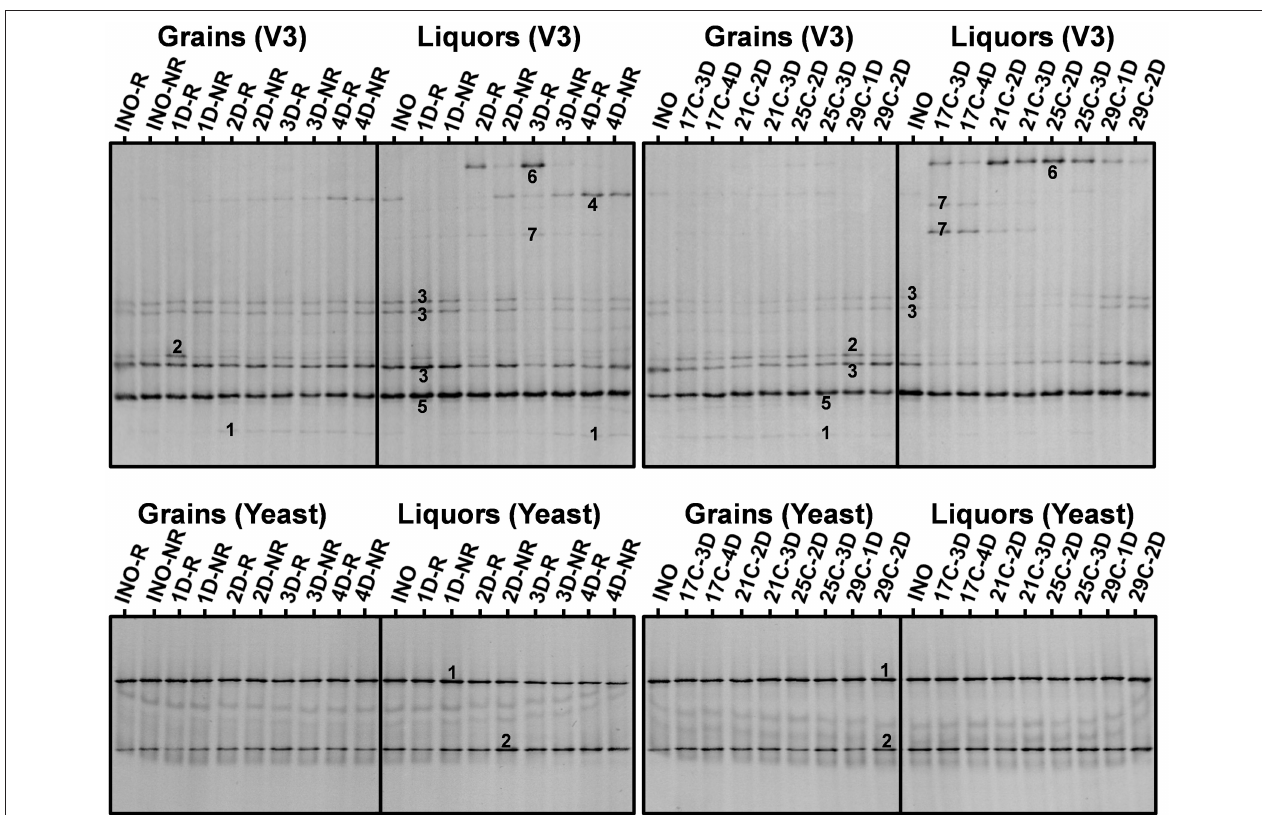
FIGURE 3 | Culture-independent species diversity of the rinsed (INO-R) and non-rinsed (INO-NR) grains and liquor of the grain inoculum (INO) and of the non-rinsed grains and liquors of the eight series of water kefir fermentations differing in backslopping time and rinsing of the grains during each backslopping step, at the end of backslopping step 8 (left), as well as of the non-rinsed grains (INO) and liquor of the grain inoculum (INO), and the non-rinsed grains and liquors of the eight series of water kefir fermentations differing in incubation temperature and backslopping time, at the end of backslopping step 8 (right). Community profiles obtained with the V3 primer pair: (1) Lacticaseibacillus casei / paracasei/zeae/rhamnosus (99% identity for all species; GenBank accession nos. LC064894/AB289229/ AB289313/JQ580982); (2) Lentilactobacillus hilgardii/diolivorans (100% identity; accession nos. LC064898/NR037004); (3) Liquorilactobacillus nagelii/ghanensis (99% identity; accession nos. NR119275/NR043896); (4) Oenococcus sicerae (99% identity; accession no. CP029684); (5) Bifidobacterium aquikefiri (100% identity; accession no. LN849254); (6) Leuconostoc pseudomesenteroides (99% identity; accession no. LC096220); and (7) Liquorilactobacillus mali/hordei (100% identity; accession nos. LC064888/NR044394). Community profiles obtained with the yeast primer pair: (1) Saccharomyces cerevisiae (100% identity; accession no. NG042623); and (2) Dekkera bruxellensis (100% identity; accession no. AY969049). C, temperature (17, 21, 25, and 29 ◦ C); D, days of backslopping (1, 2, 3, or 4); R, rinsed; NR,